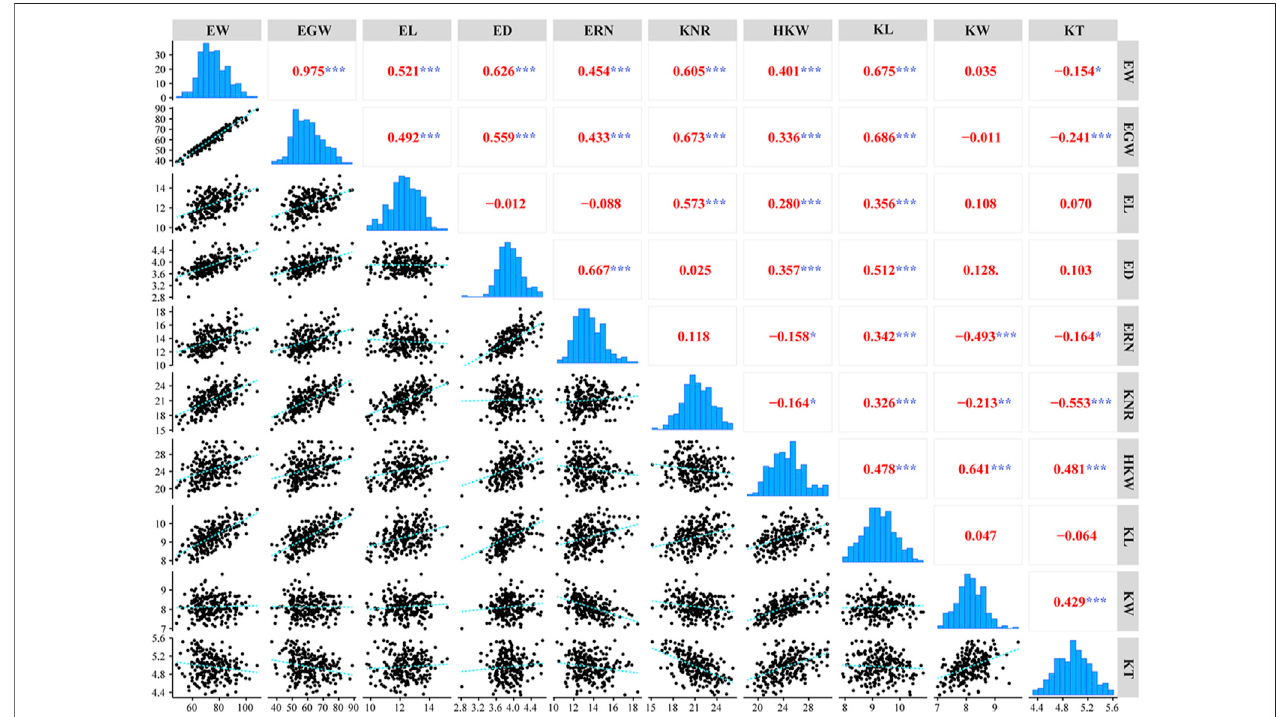
FIGURE 1 | Phenotypic distribution and Pearson correlation coef fi cients for ten ear-related traits (***, p < 0.001; **, p < 0.01; *, p < 0.05).